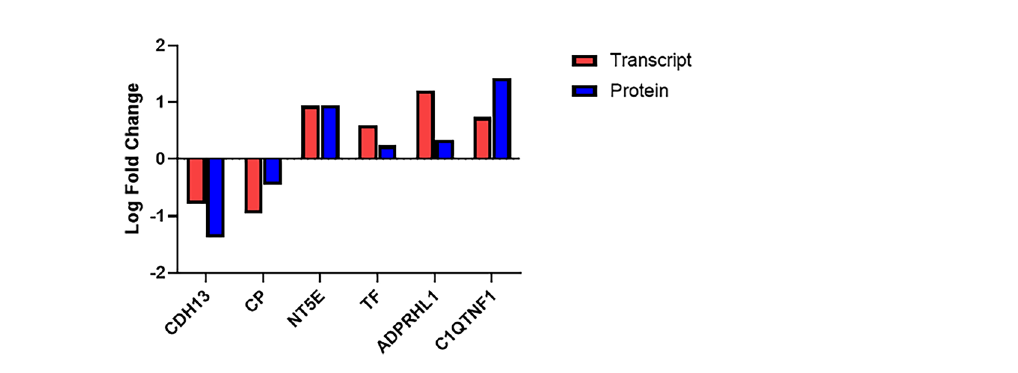
Figure 3. Comparison of expression between DE-mRNA transcripts identified within the proteomic dataset of the testes